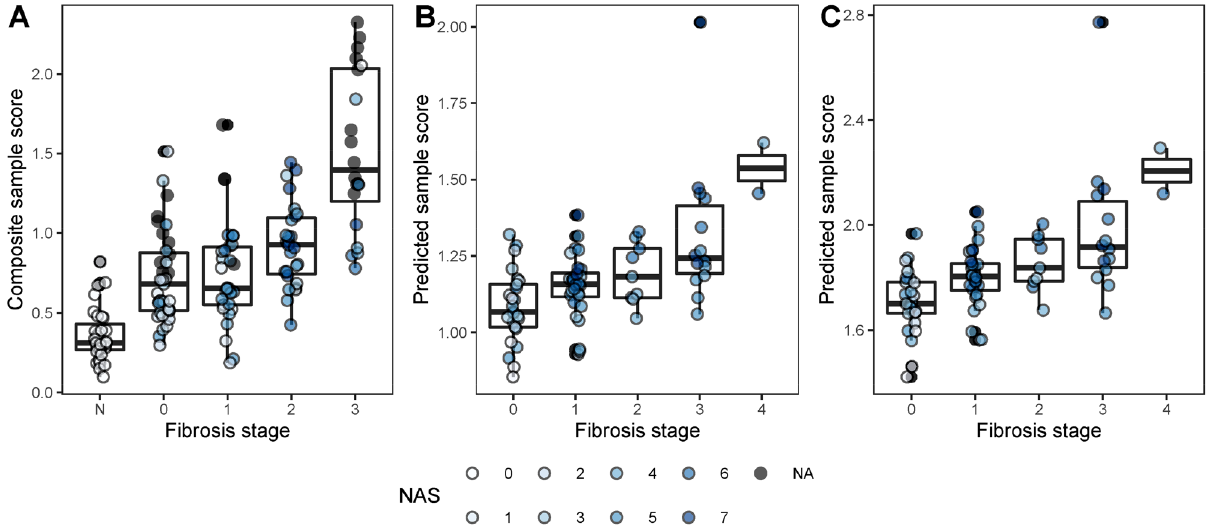
Figure 5. Gene signature. ( A ) Relationship between composite sample score and fibrosis stage in the NASH data. Validation of 26- ( B ) and 98-gene ( C ) signatures using data from Hoang et al. (7).